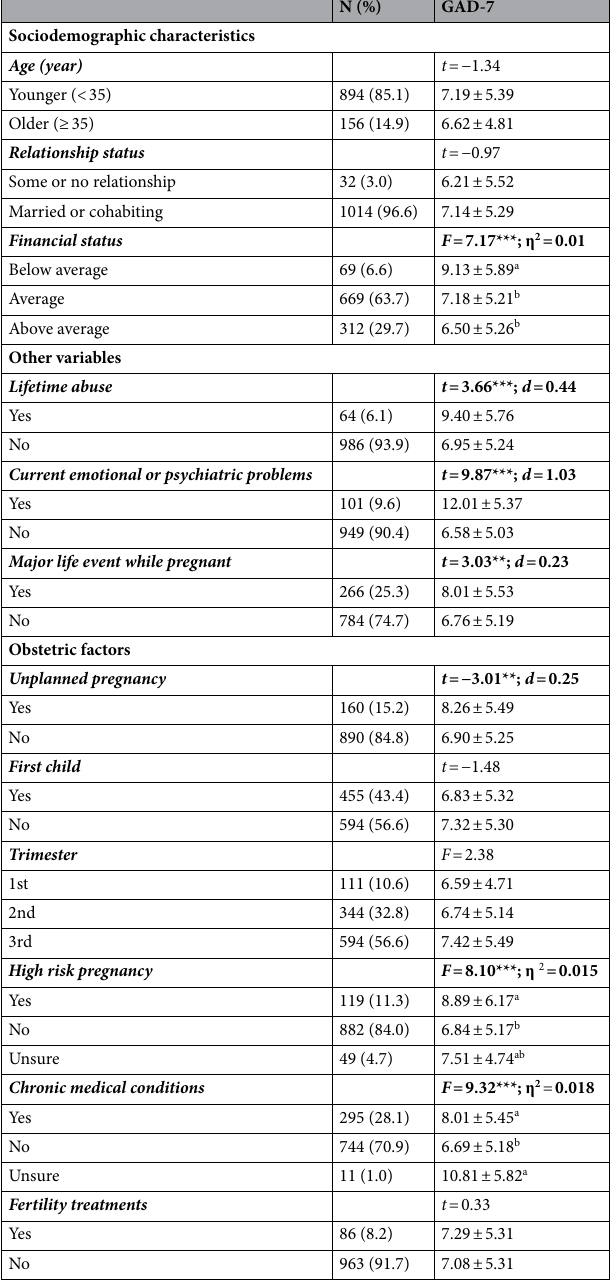
Table 1. Sample characteristics and mean differences in GAD-7 scale score based on sociodemographic characteristics, obstetric factors, and other predictors (N = 1050). * p < . 05; ** p < . 01; *** p < . 001. Estimates of effect sizes: d—Cohen’s d; η 2 —eta squared. Means with different superscripts are significantly different at p < 0.05 in a post hoc Scheffé